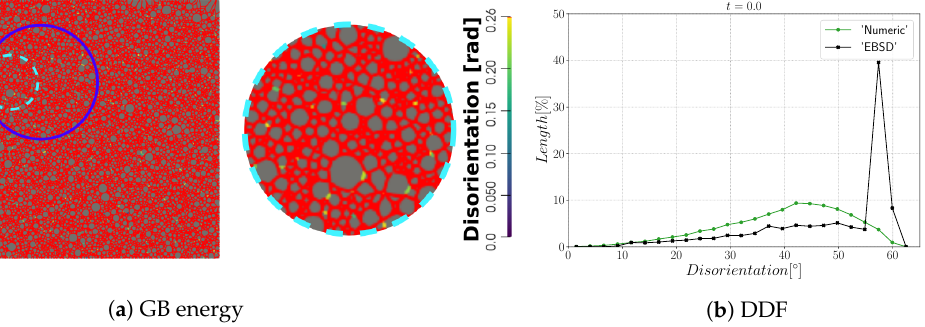
Figure 13. Initial ( a ) microstructure disorientation with a cyan circle that represents the zone shown on the right and ( b ) the disorientation